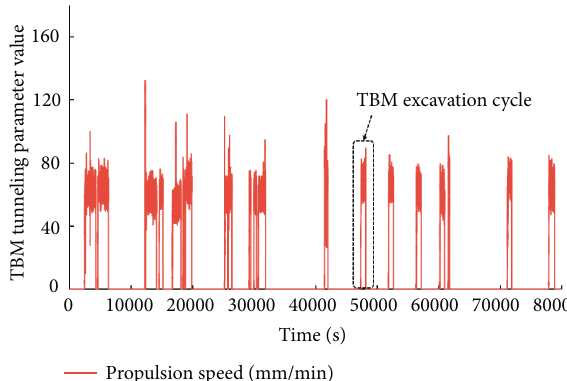
Figure 6: Variation curve of TBM tunneling parameters on a certain day.